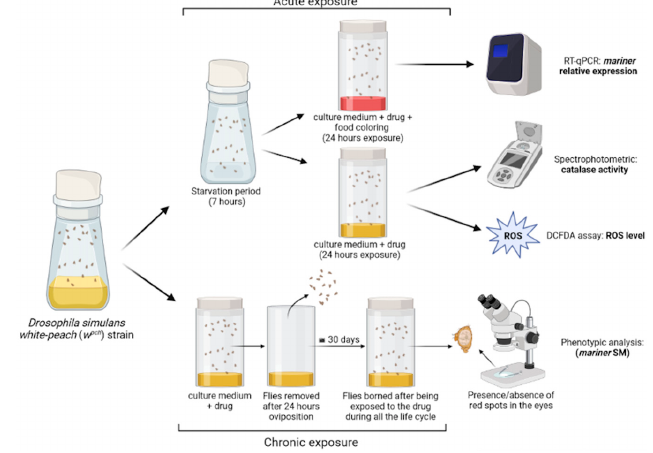
Figure 1. Experimental design. Acute exposure: 1-to-4-day-old D. simulans w pch flies were subjected to a 7-hour starvation and then transferred to culture media containing cisplatin, dacarbazine, or daunorubicin plus food coloring dye for further analysis. No dye was added to the culture media of the flies used for the biochemical analyses. Chronic exposure: flies were oviposited for 24 h in culture media containing one of the active compounds, and the new generation was collected and analyzed. Created with BioRender.com October 25th, 2022, Licence AD24KGDIHQ. The concentrations of each chemotherapy drug used were based on previously published studies. Cisplatin [34] and dacarbazine [35] were mixed to the culture media at 50 and 100 µg/mL, respectively. Daunorubicin was mixed to the media at a concentration of 25 and 50 µM [36]. RNA extraction was performed according to the TRIzol™ Reagent protocol (Invitrogen). RNA concentration was analyzed using the NanoDrop 2000 spectrophotometer (Thermo Fisher Scientific, Waltham, USA). Samples were then treated with DNaseI (Promega, Madison, USA) and synthesis of complementary DNA (cDNA) was performed using random primers according to the instructions of the High-Capacity cDNA Reverse Transcription Kit (Thermo Fisher Scientific). The relative expression of the mariner transposase gene was measured through RT- qPCR on the StepOnePlus equipment (Applied Biosystems, Waltham, USA) and SYBR Green was used as a fluorophore. The reaction was carried out in a final volume of 20 µL containing 10 µL of diluted cDNA (1:100), 0.25 U Platinum Taq DNA polymerase (Invitrogen, Waltham, USA), 1× PCR reaction buffer, 3 mM MgCl 2 , 25 µM dNTPs 0.2 µM of each reverse and forward primer, and 1× SYBR Green (Molecular Probes, Eugene, USA). To verify the relative expression of mariner , primers Mos308_F (GTGAACGGTGGTTTCAACG) and Mos490_R (AGCGATTGGAAACTGCTTGT) [13,37] were used, amplifying a 184 bp fragment. As endogenous control, the RP49 ribosomal protein